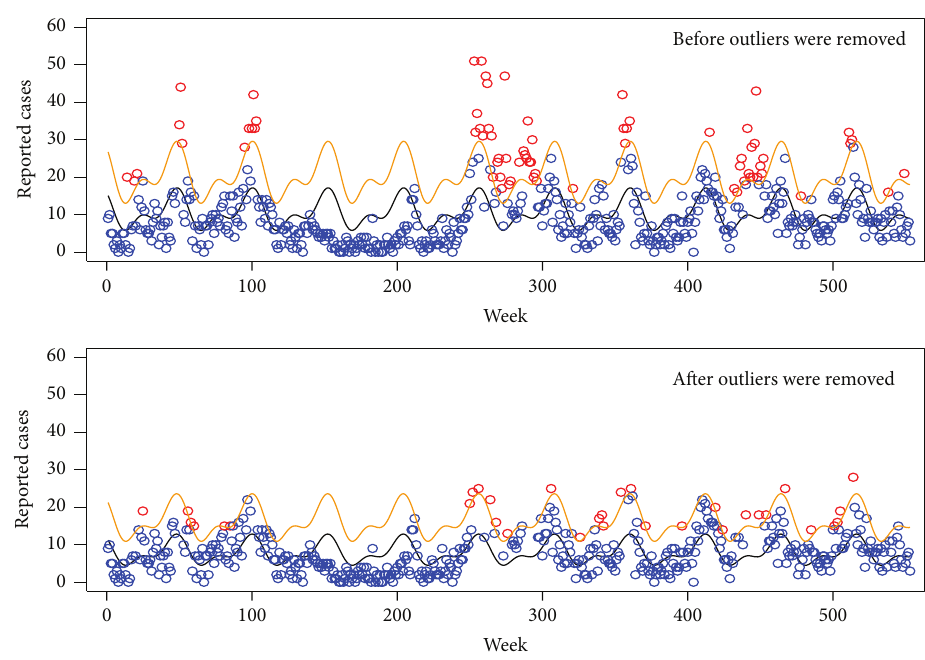
Figure 7: Negative binomial fit to pertussis data (top), where points above UCL are shown in red. After these points were removed, the negative binomial was fit again, with the results shown in the